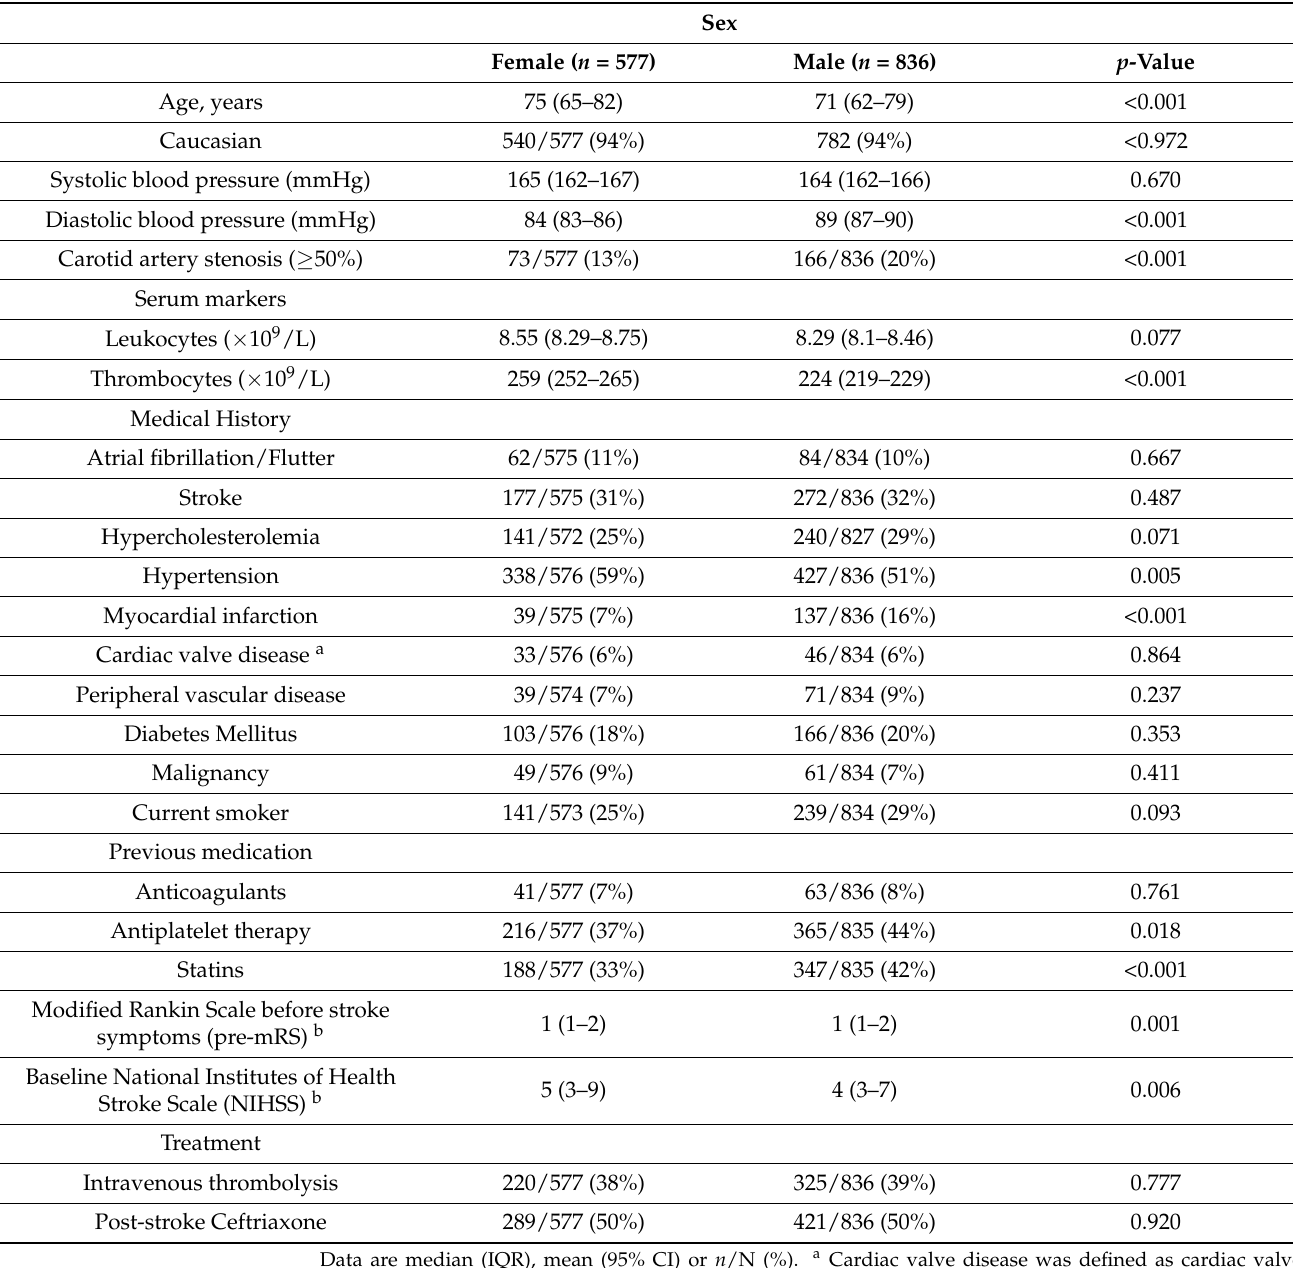
Table 1. Baseline